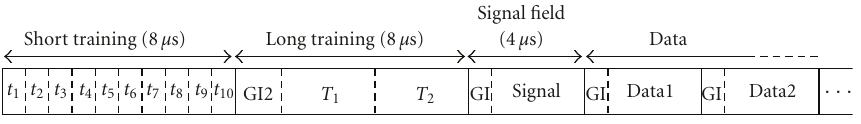
Figure 4: Packet format in IEEE 802.11a.